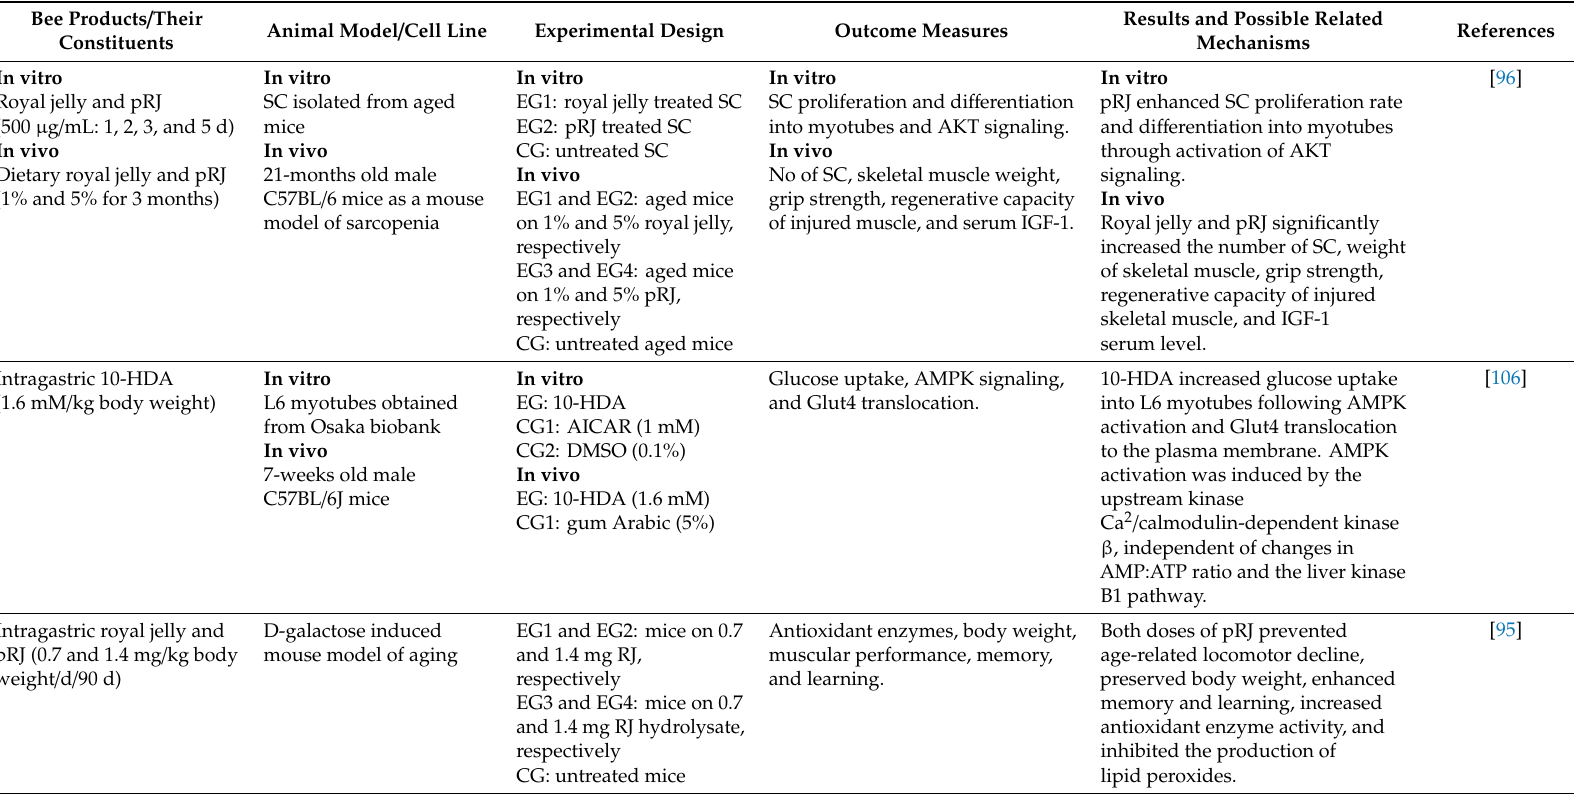
Table 1. Characteristics of Included Pre-Clinical and Clinical Studies Examining the E ff ect of Royal Jelly, Propolis, Bee Pollen, and their Constituents on Skeletal Muscle (N of studies =